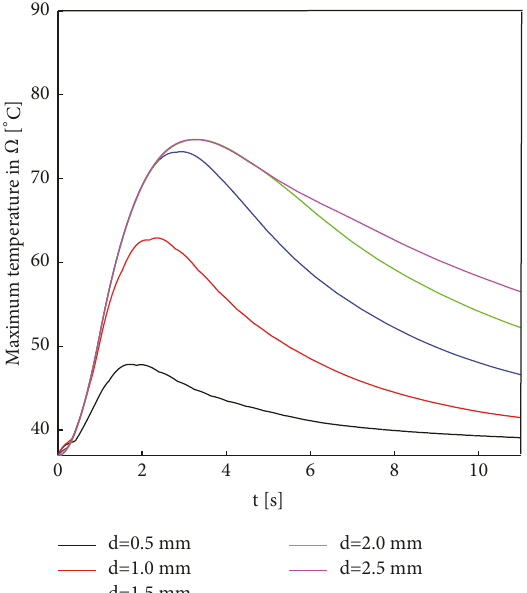
Figure 6: Maximum temperature in space 𝑟, 𝑧 ∈ Ω versus time with different distance 𝑑 for 𝑝 0 = 1.5 × 10 5 𝑝𝑎 , 𝑟 0 = 1𝑚𝑚 , 𝜏 = 1.756 𝑠 , 𝑢 = 5 𝑐𝑚/𝑠 , 𝑓 = 1𝐻𝑧 , 𝑓𝑎𝑐 = 0.5 , 𝑡 = 1 𝑠 𝑎 V 𝑒 𝑝 ℎ